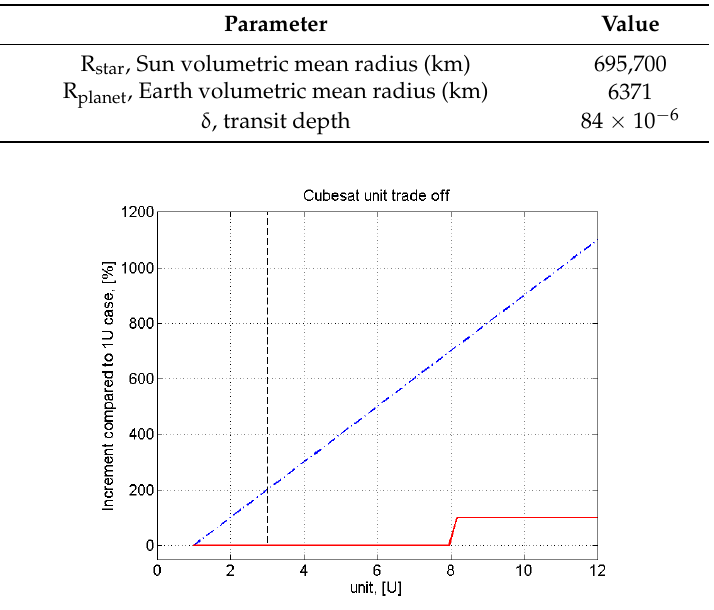
Figure 2. Cubesat unit tradeoff. The red line represents the available objective aperture size (D) of the payload as a function of the number of units. The blue dash-dot line is a first approximation cost (C) as a function of the unit number. The cost trend follows the linear mass increment trend as the unit number grows. Since the aperture shape in question is circular, D is unchanged until 8 units, which is the minimum number of units to build a square cubesat with a face size of 2 units. The black dashed line corresponds to the 3U cubesat size.